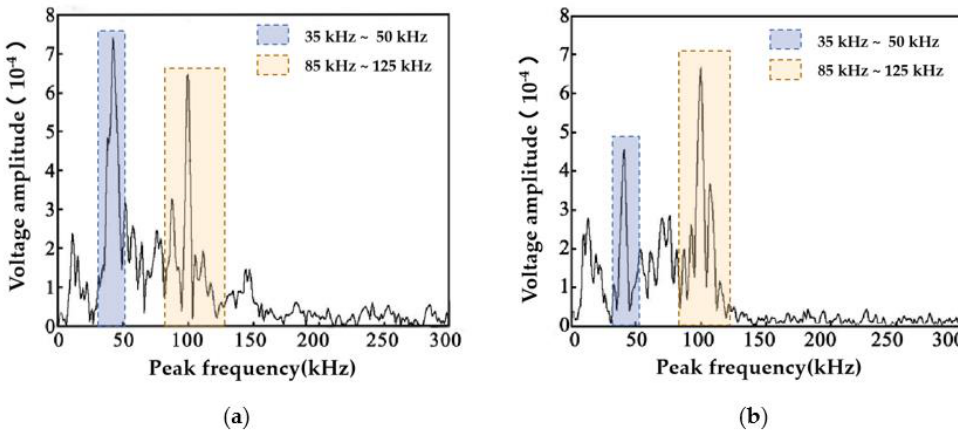
Figure 13. FFT spectrum characteristic maps: ( a ) cluster 1; ( b ) cluster 3.